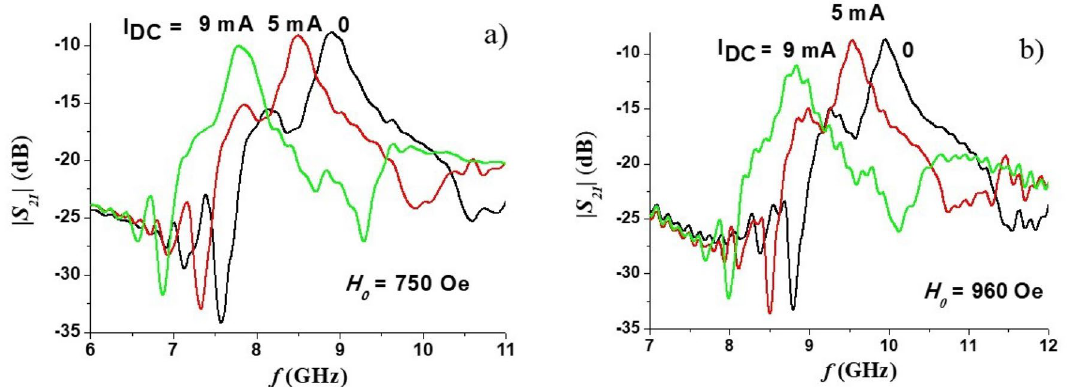
Figure 8. Pass-band electrical tuning characteristics of the band pass filter by applied DC current for ( a ) H 0 = 750 Oe and ( b ) H 0 = 960.